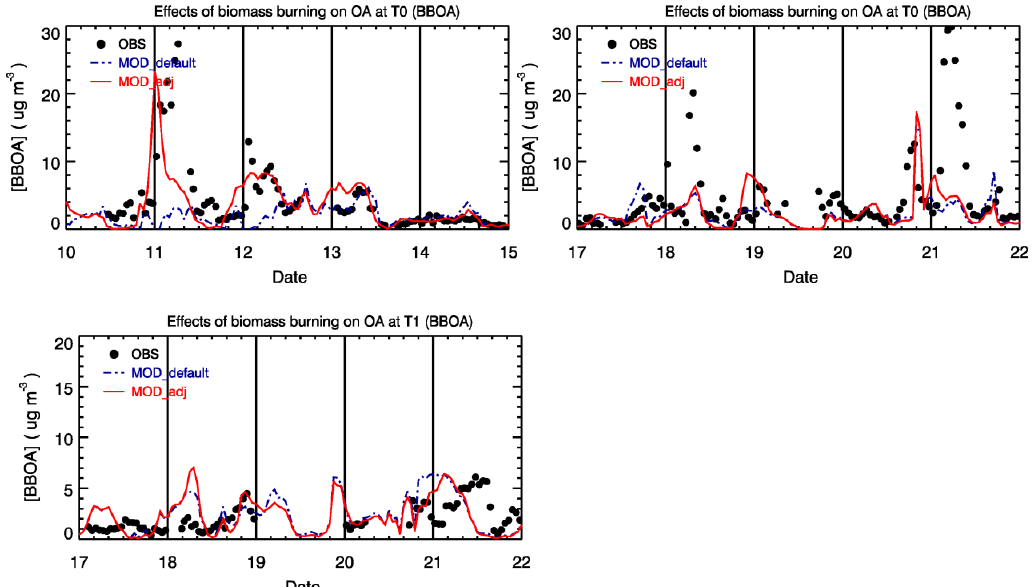
Fig. 6. 1230 Fig. 6. Comparisons of AMS-derived and simulated BBPOA concentrations at T0 during 10–14 March and at T0 and T1 during 17–21 March. The black dots represent AMS PMF data, the dashed blue lines represent the simulations with the default BB emissions, and the red lines represent the simulations with the adjusted BB emissions. Details of the BB emissions are described in the main